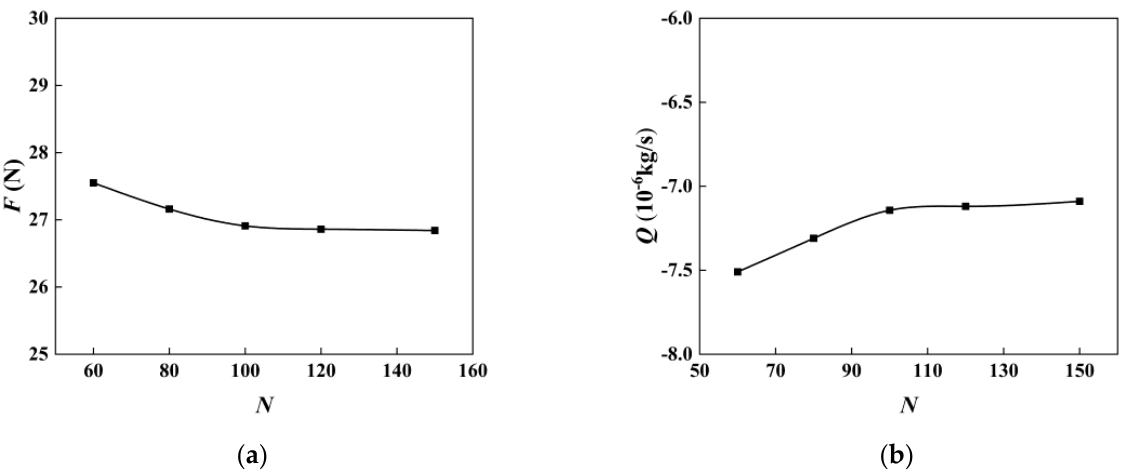
the values of F and Q only changed slightly. Therefore, N = 100 was used to simulate the grooved zone. Based on the size of the surface, N = 200 was used to simulate the stationary ring surface and non-grooved zone of the rotating ring.